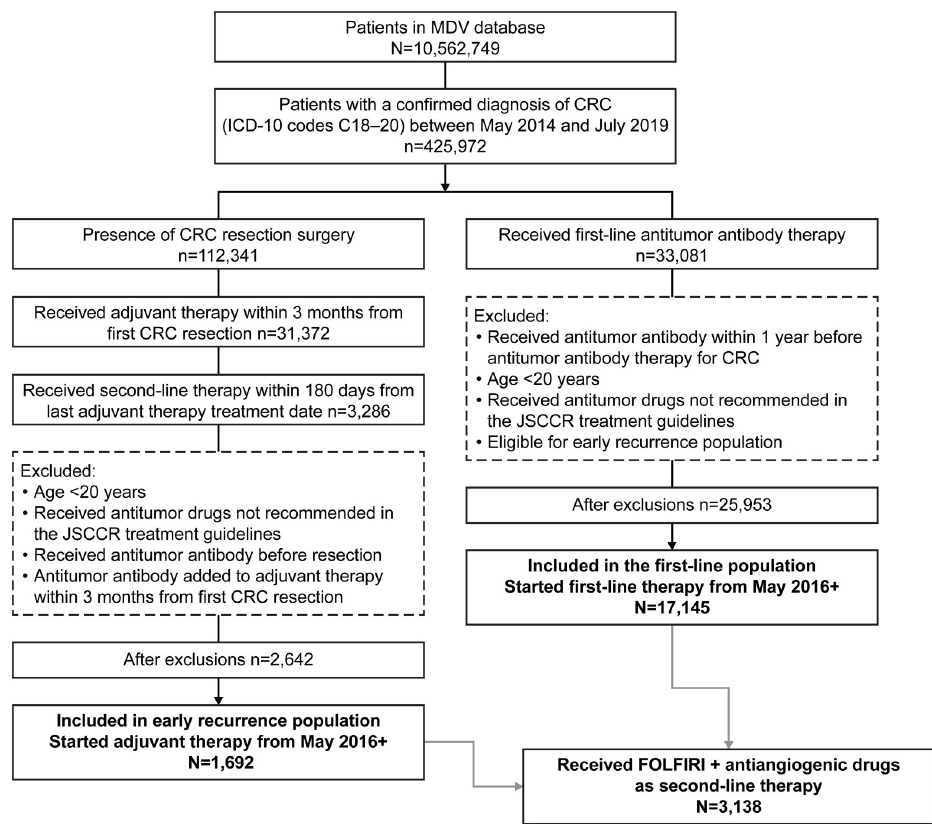
Fig 1. Patient flow diagram. MDV, Medical Data Vision; ICD-10, International Statistical Classification of Diseases and Related Health Problems , 10 th Revision ; CRC, colorectal cancer; JSCCR, Japanese Society for Cancer of the Colon and Rectum; FOLFIRI, leucovorin, 5-fluorouracil, and irinotecan.